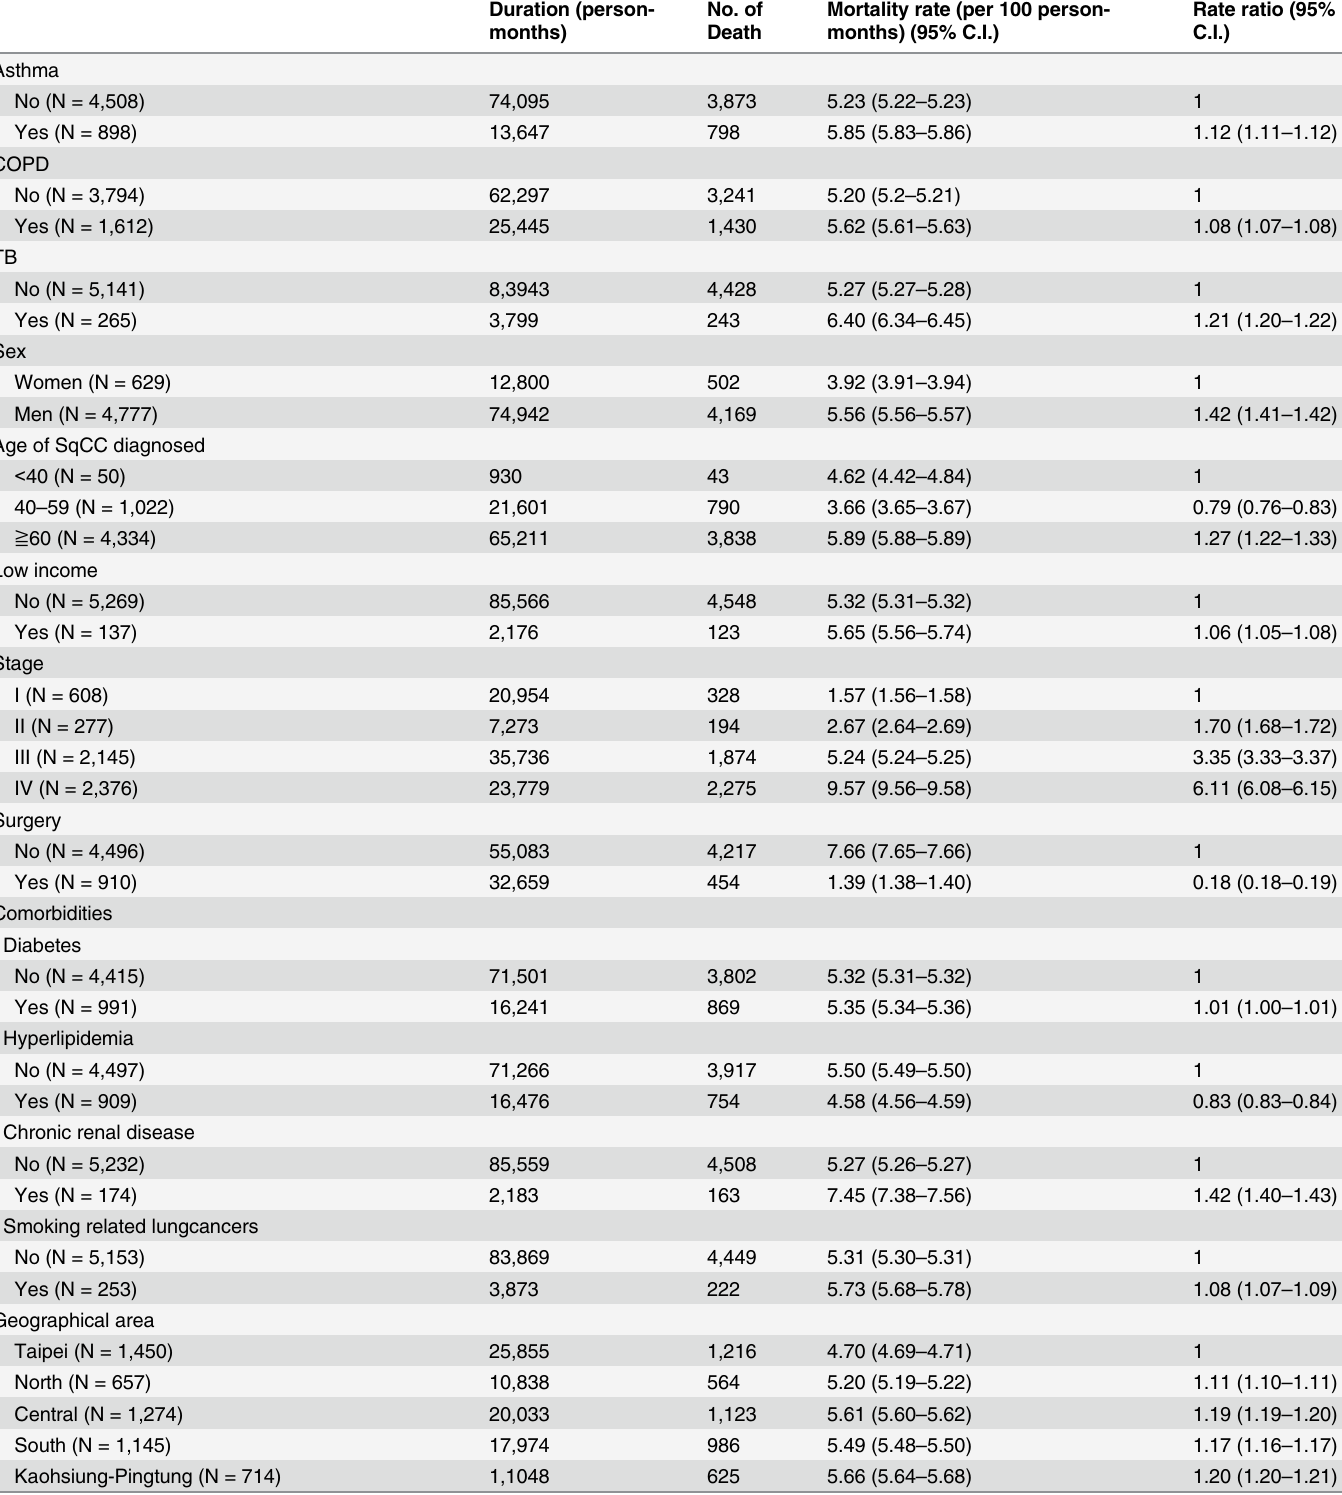
Table 1. Characteristics of patients with lung squamous cell carcinoma and all-cause mortality, Taiwan, 2003 – 2010.